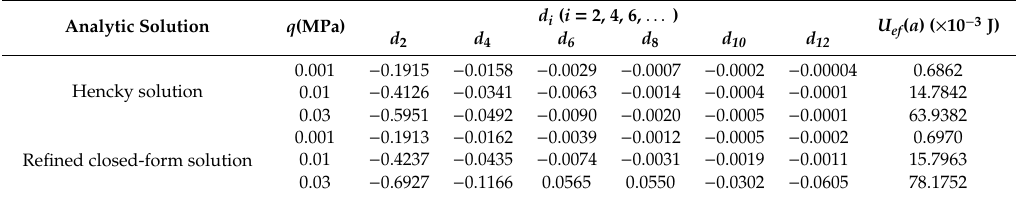
Table 1. The coe ffi cients d i and the elastic strain energy U ef ( a ) stored in blistering film. Analytic